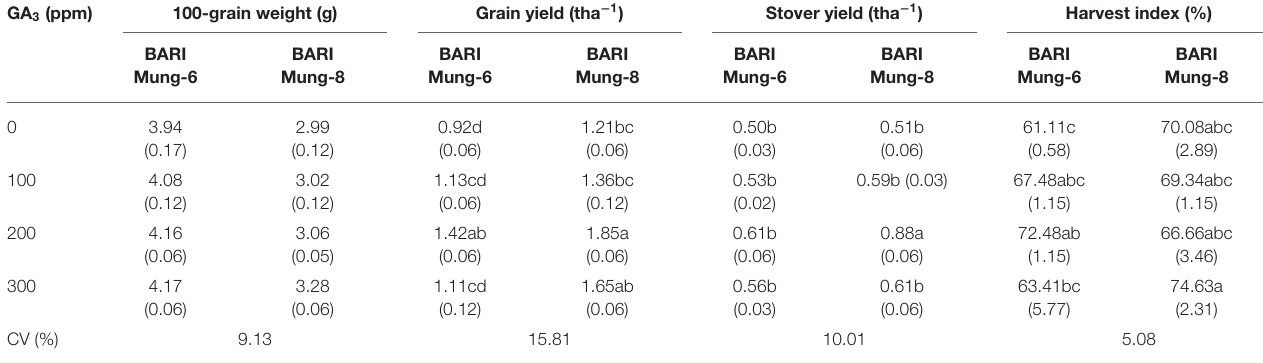
TABLE 8 | Effect of different concentration of GA 3 on 100-grain weight (g), grain yield (tha − 1 ), stover yield (tha − 1 ), and harvest index (%) of V. radiate . GA 3